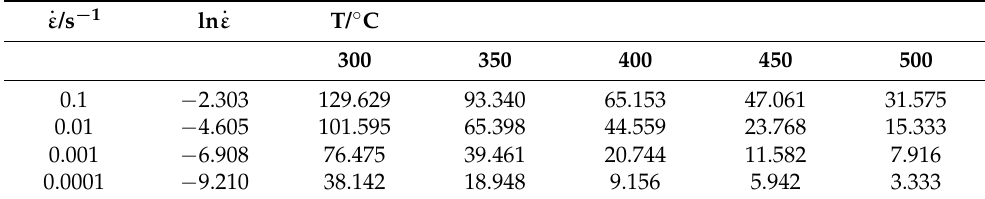
Table 2. Peak stresses at different temperatures and strain rates.